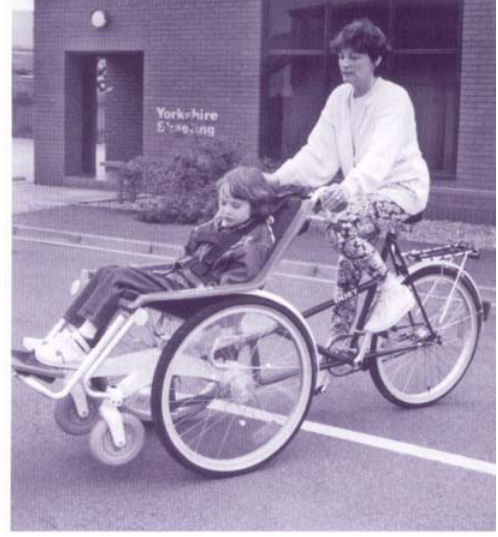
PICTURE 28. Duet wheelchair tricycles.